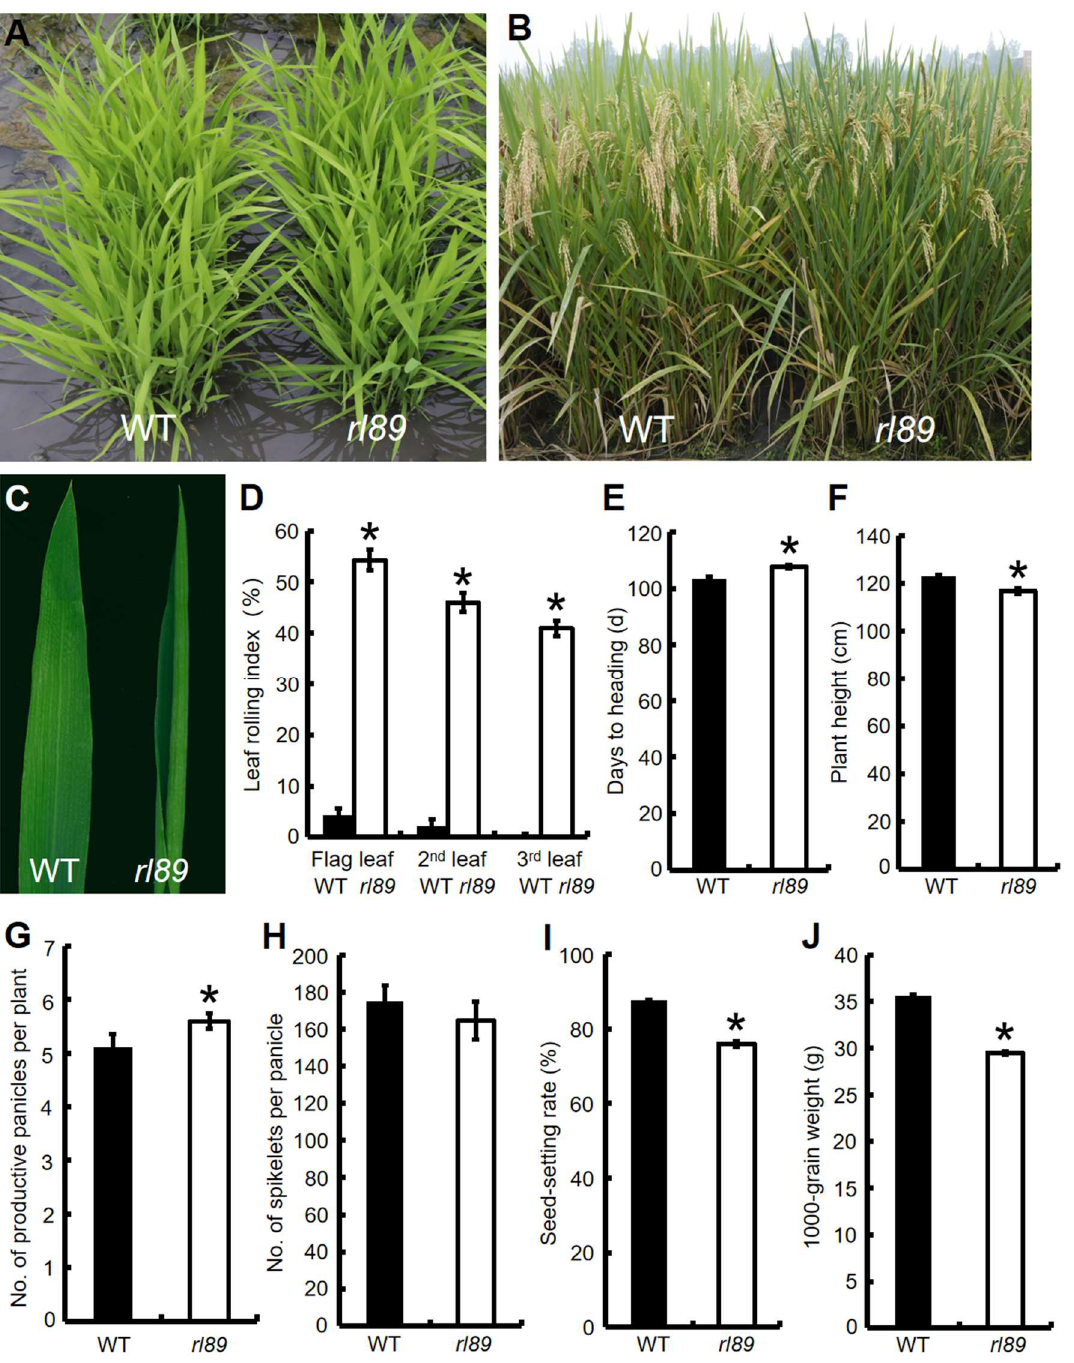
Figure 1. Comparison of plant phenotypes and major agronomical traits between rl89 mutant and its wild type (WT). ( A ) Seedlings at the four-leaf stage. ( B ) Plants in the field at the grain-filling stage. ( C ) Flag leaf at the heading stage. ( D ) Leaf rolling indexes (LRIs) of the top three leaves (the flag, 2nd, and 3rd leaves from the top of main stem of a single plant) at the heading stage. ( E ) Days to heading. ( F ) Plant height. ( G ) No. of productive panicles per plant. ( H ) No. of spikelets per panicle. ( I ) Seed setting rate. ( J ) 1000-grain weight. Bars represent standard deviations (SDs) of three independent experiments in ( D – J ), respectively. * indicates statistically significant difference compared to the wild type at p < 0.05.